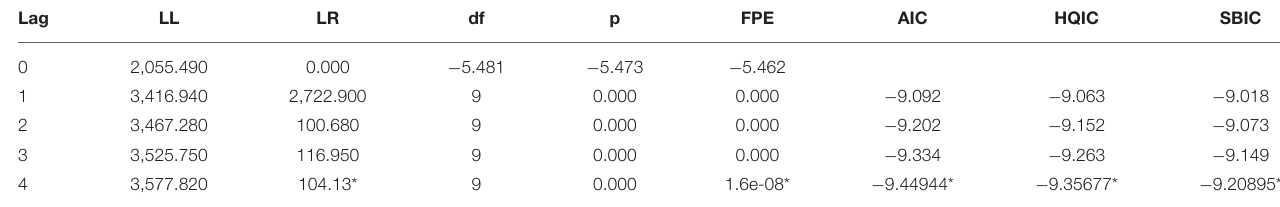
TABLE 4 | Lagtest.